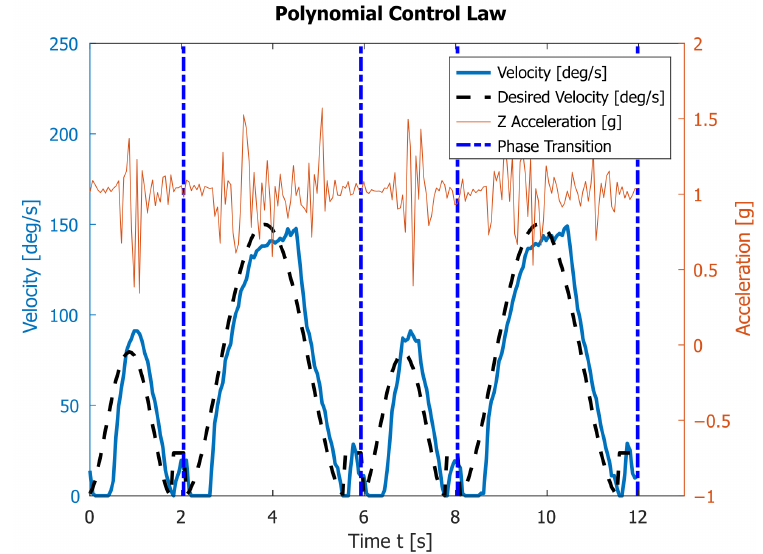
Figure 9. The angular velocity read by the encoder and the vertical acceleration obtained by the accelerometer during the motion of link 4 subjected to the polynomial control law.